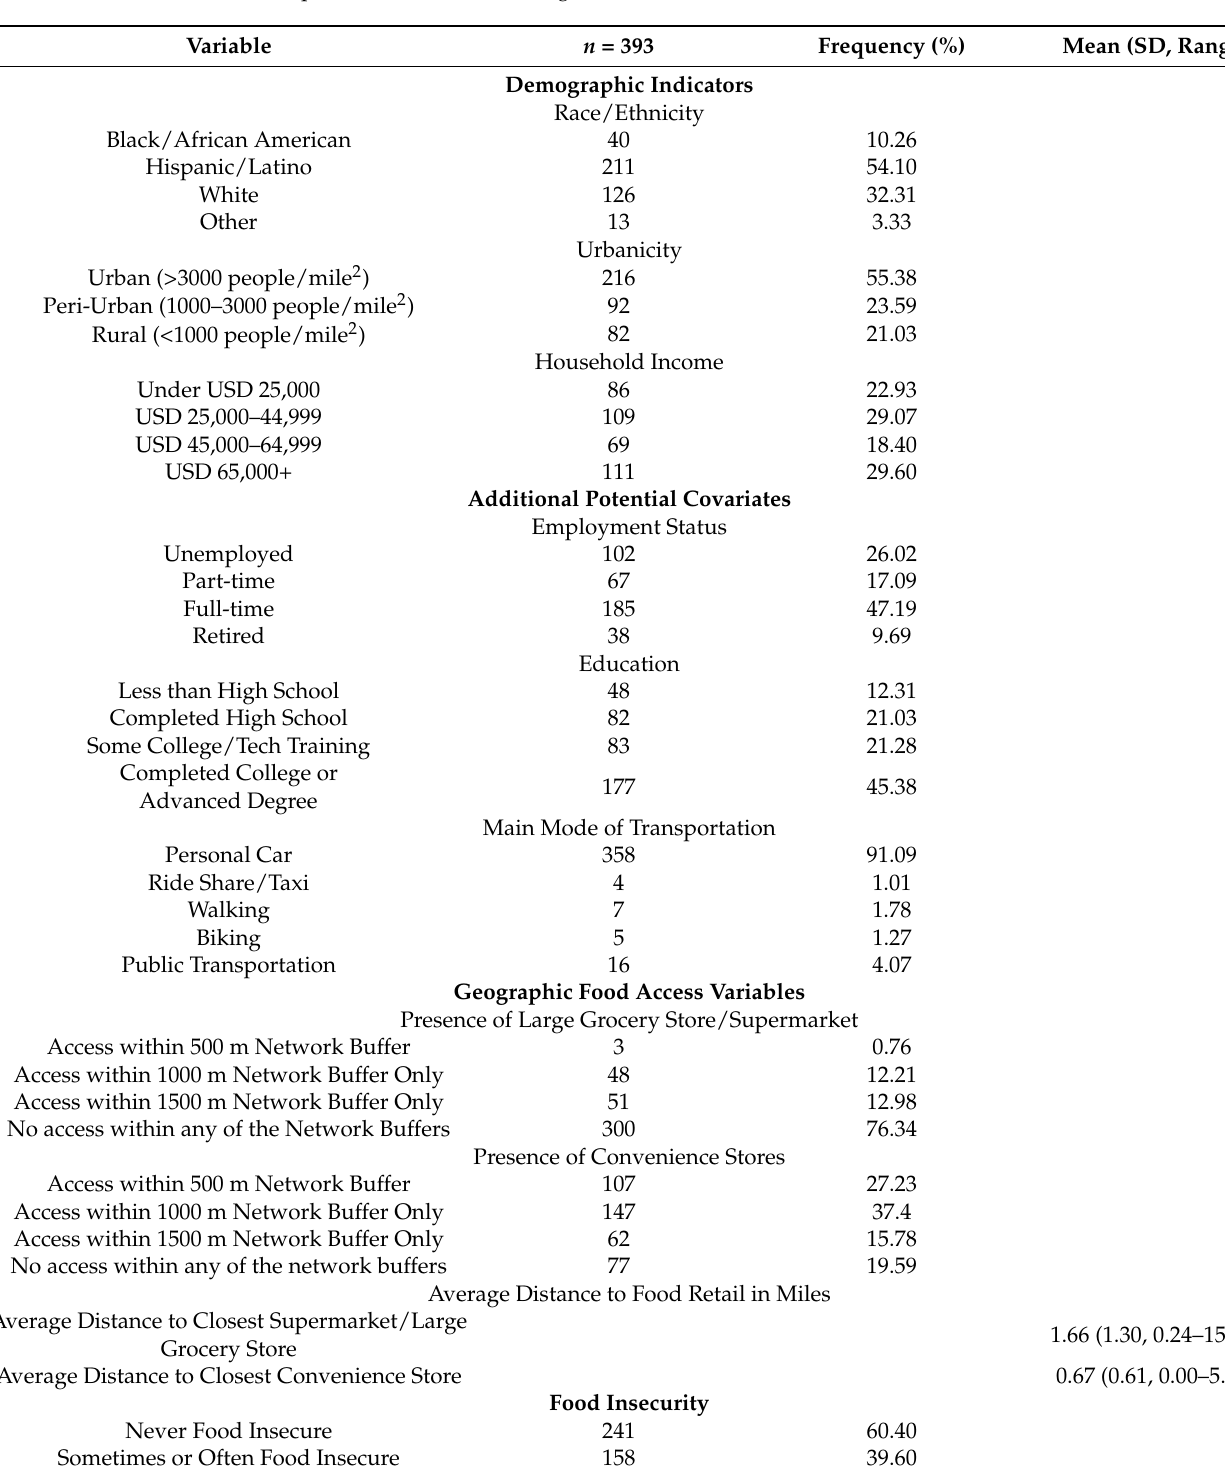
Table 1. Descriptive statistics for geographic food access, food insecurity, and various indicators and potential covariates among the FRESH-Austin